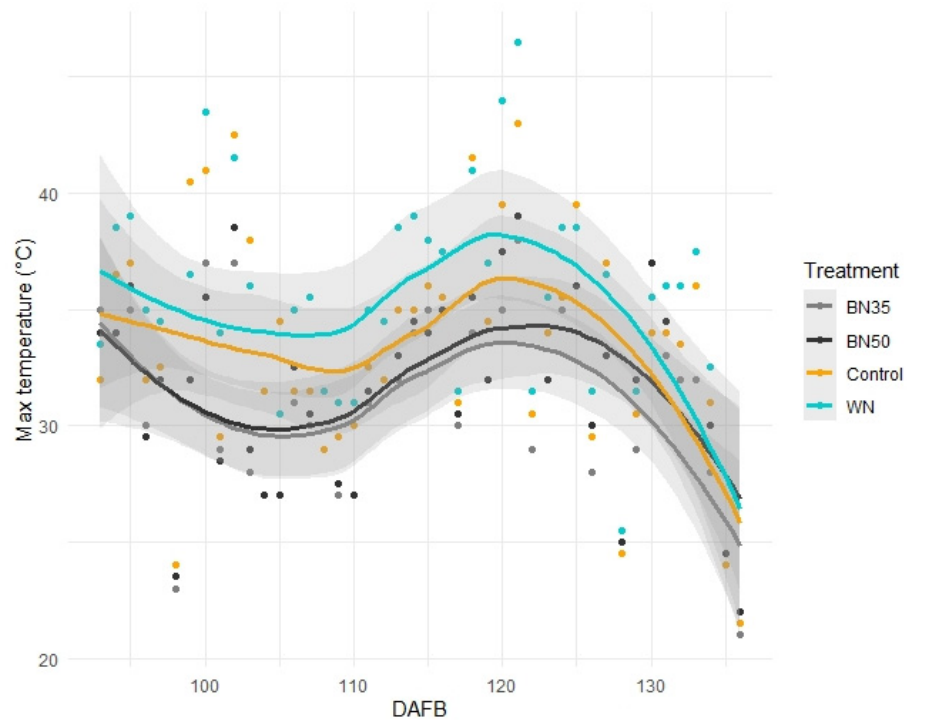
Figure 2. Evaluation of the maximum air temperature in the treatments under netting (BN35 = Black net 35, BN50 = Black net 50, WN = White net) and the Control treatment. DAFB = days after full bloom in season 4. Dots represent the maximum daily temperature. Lines and 0.95 confidence intervals were calculated according to the geom_smooth function (loess method in R).